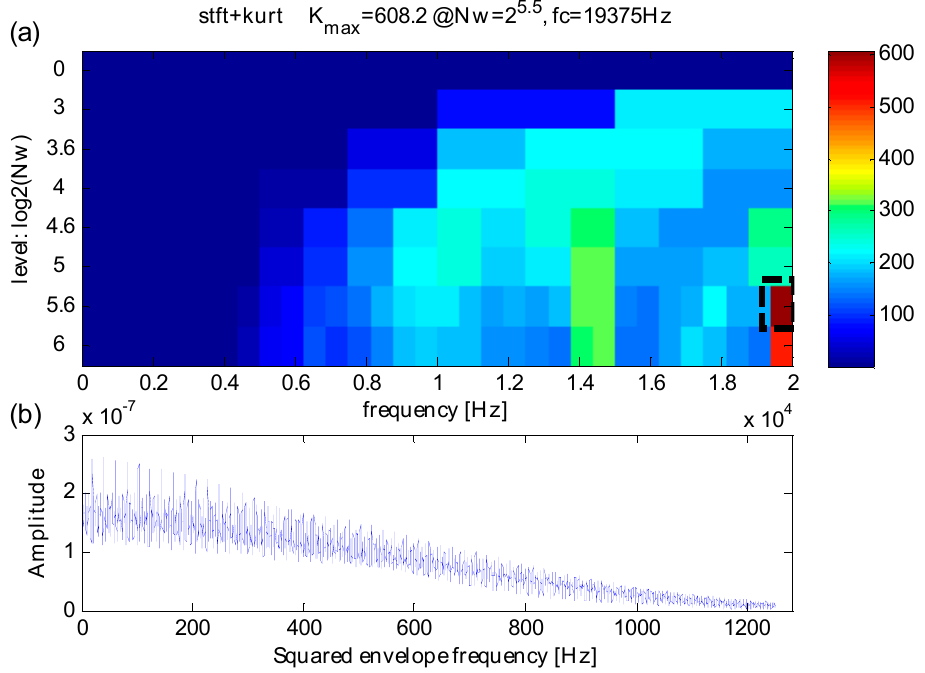
Figure 20. ( a ) The kurtogram; ( b ) the squared envelope spectrum of the frequency band with the maximum kurtosis.